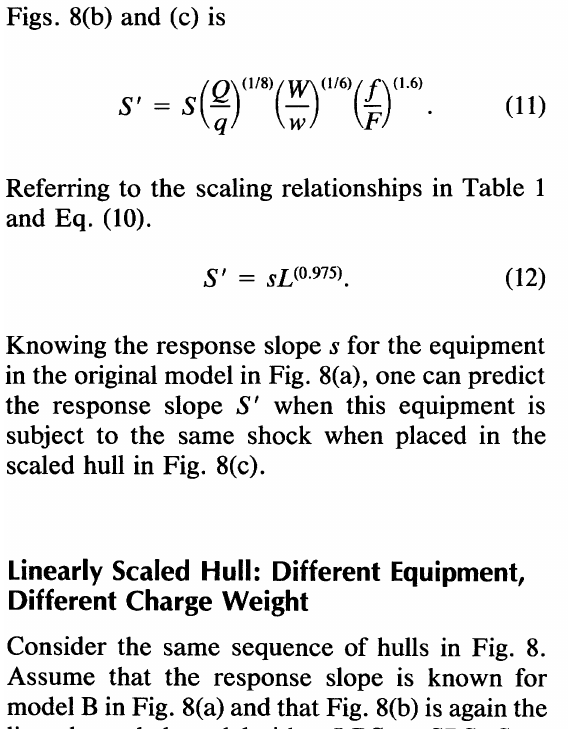
FIGURE 9 Absolute percent errors in predicted slopes using Eq. (12) for six charge weights, equip ment weights of 15,20, and 25 kips; f= 20 and 30 Hz; (a) model SB; (b) model